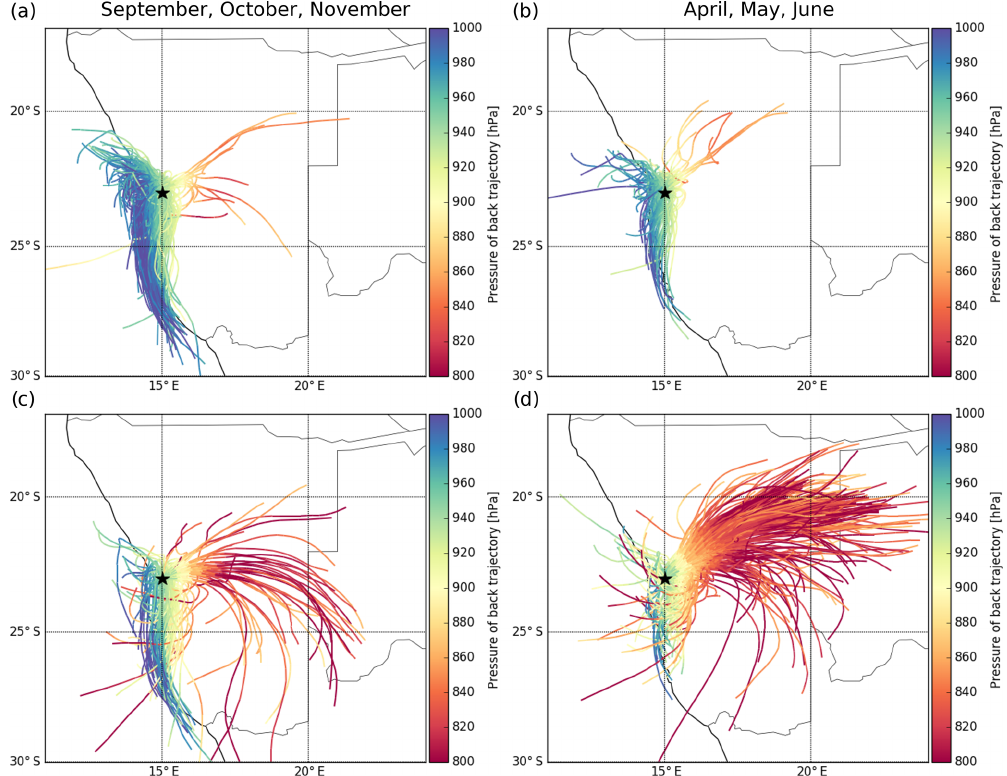
Figure 7. The 24h LAGRANTO air-mass back trajectories for (a, b) FLC days and (c, d) clear days in (a, c) September, October, and November and (b, d) April, May, and June for 2004–2017. The star marks 23 ◦ S and 15 ◦ E, where the back trajectories were initialized at 25hPa (approximates 200m) above ground level. The number of samples are (a) 399, (b) 133, (c) 146, and (d)